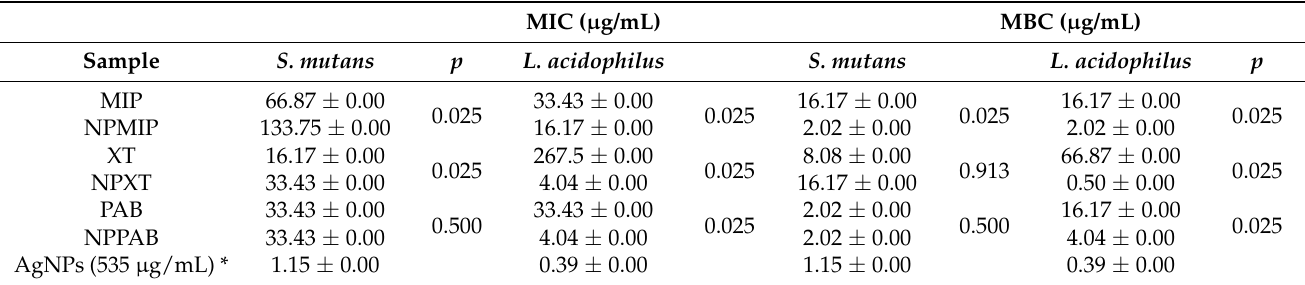
Table 3. Minimum inhibitory concentration and minimal bactericidal concentration of the samples tested in this